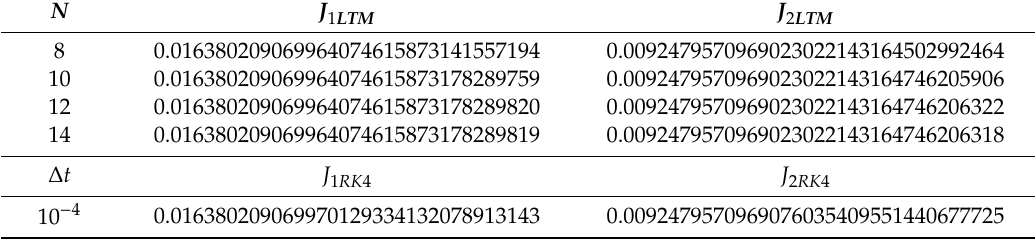
Table 1. Optimal payo ff functionals J 1 and J 2 for illustrative example with LTM as compared with RK4. N